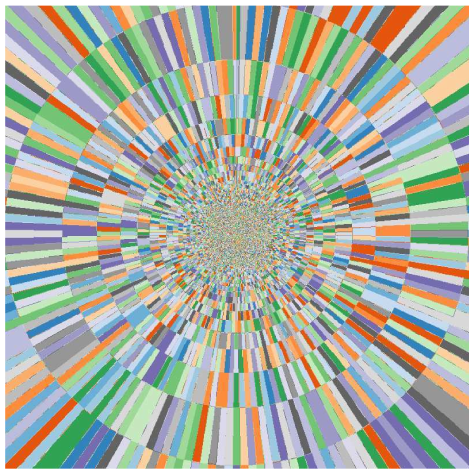
Figure 5. Dartboard: each radial sector is covered by a different scanner layer.